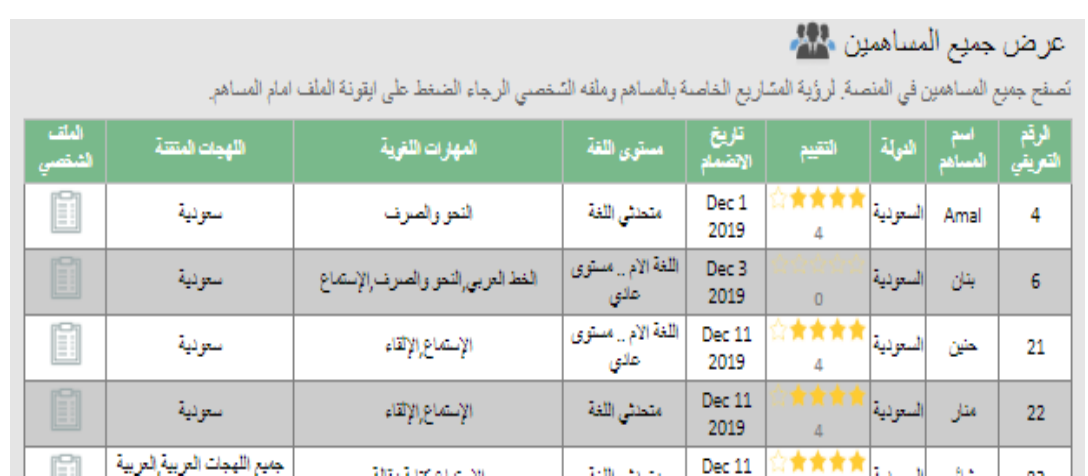
Figure 5. Contributor skills filter result.